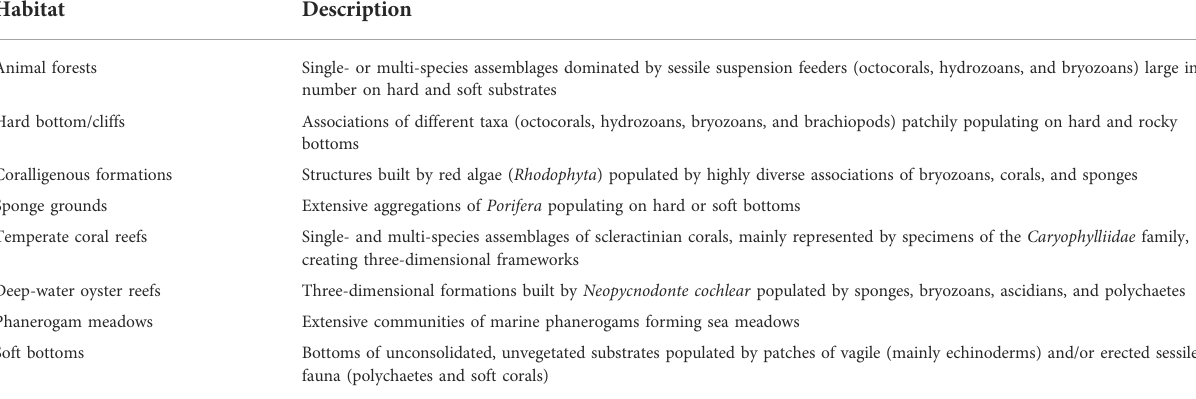
TABLE 1 Description of the target mesophotic habitats from the literature analysis. De fi nitions reported here summarize those provided in the bibliographic records. See Supplementary Table S1 for further information.